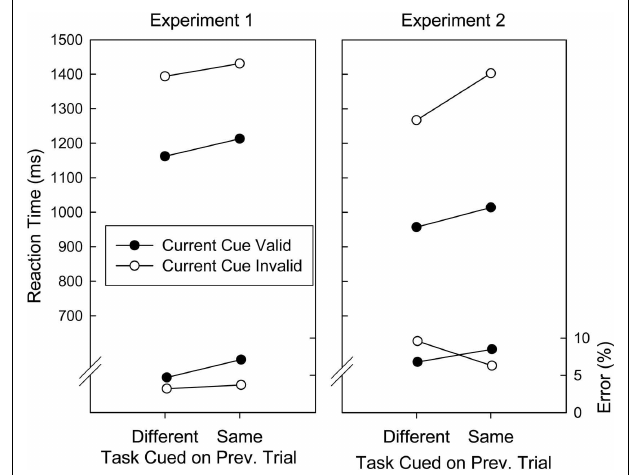
FIGURE 2 | Mean reaction times and error proportions of Experiment 1 and 2 for task switch trials following an invalidly cued trial as a function of cuing validity and whether the switch was made to the previously (invalidly) cued